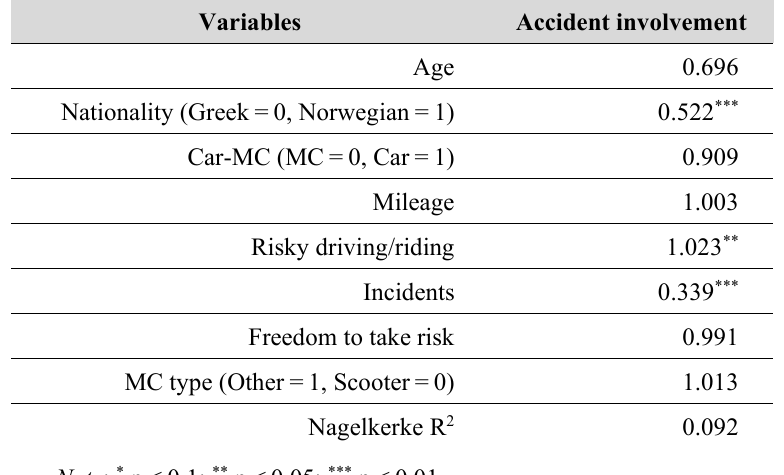
Table 6 Logistic regression, odds ratios; dependent variable: ‘ Accident involvement ’ (No accident: 0, Accident: